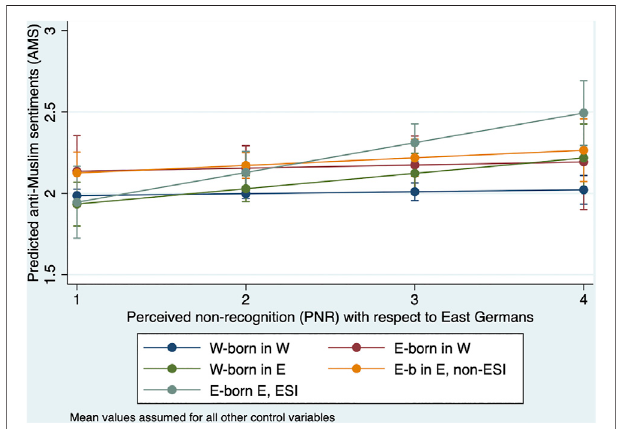
FIGURE 3 | Predicted anti-Muslim sentiments (AMS) for different East- West types dependent on perceived non-recognition (PNR) with respect to East-Germans.